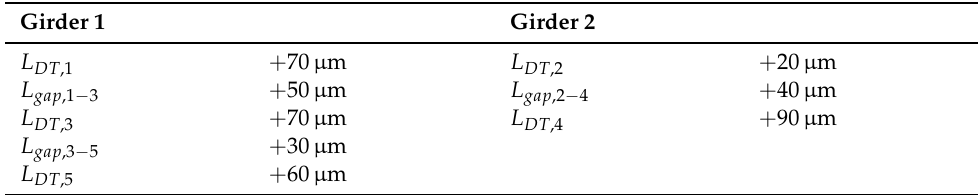
Table 1. Deviation of Measured Dimensions from the Original Design